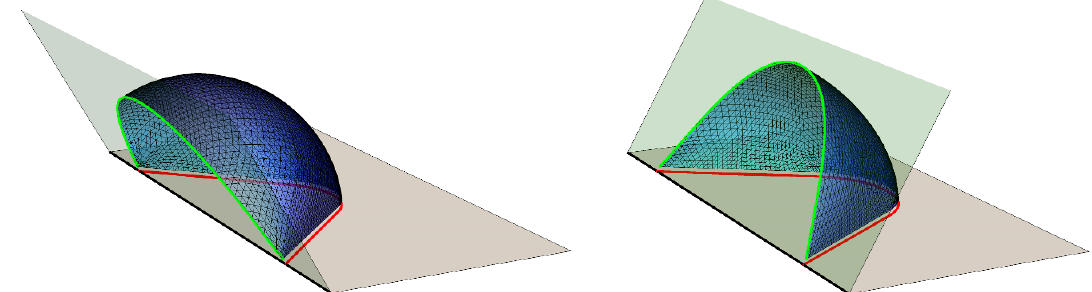
Figure 13 . Minimal surfaces ^ (cid:13) A obtained with Surface Evolver corresponding to a region A delimited by the red curve (entangling curve @A \ @B ) in the grey half plane at z = 0, which has been obtained by smoothly joining two segments of equal length L forming two equal corners with the boundary, whose opening angle is (cid:13) . The green half plane is Q de(cid:12)ned by (4.3) and the green curve corresponds to ^ (cid:13) A \ Q . In the left panel (cid:11) = (cid:25)= 3, L = 1 and (cid:13) = 0 : 8, while in the right panel (cid:11) = 2 (cid:25)= 3, L = 1 and (cid:13) = 1. The numerical data of the corner function F (cid:11) ( (cid:13) ) corresponding to this kind of domains are labeled by empty triangles in (cid:12)gure